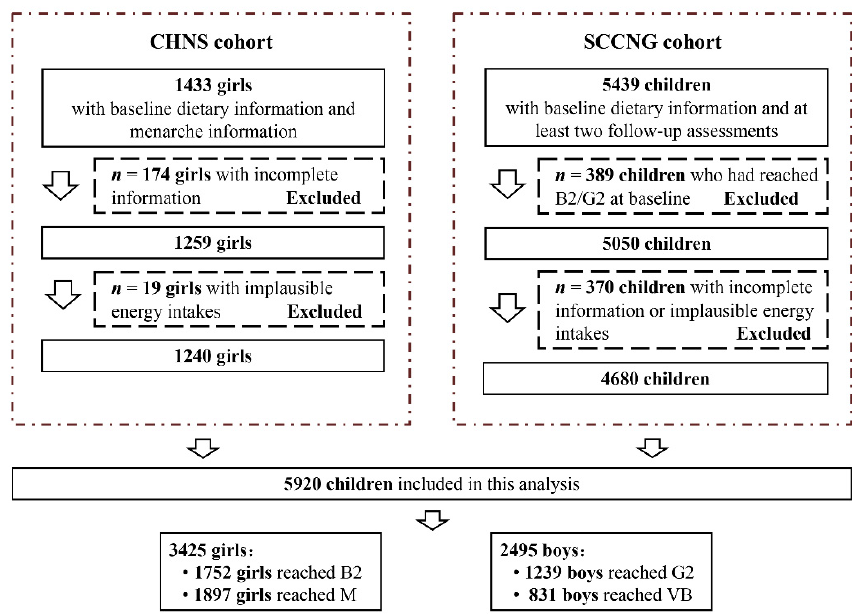
Figure 1. Flow chart for the study sample in our study. CHNS, China Health and Nutrition Survey; SCCNG, Southwest China Childhood Nutrition and Growth; B2, Tanner stage 2 for breast development; G2, Tanner stage for genital development; M, menarche; VB, voice break.